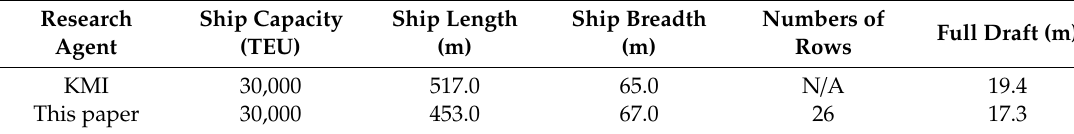
Table 8. Comparison between dimensions of 30,000 TEU ships.